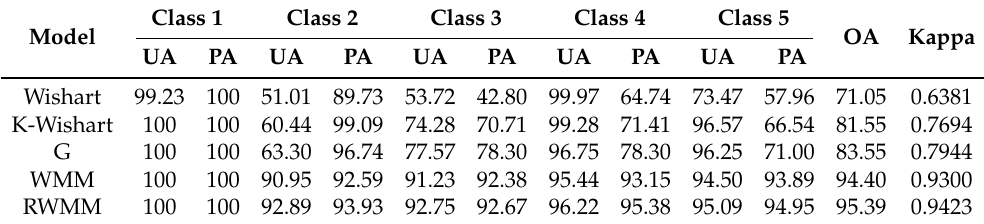
Table 1. The ML-Based Classification Accuracy (%) Comparison of Five Models on the Simulated PolSAR